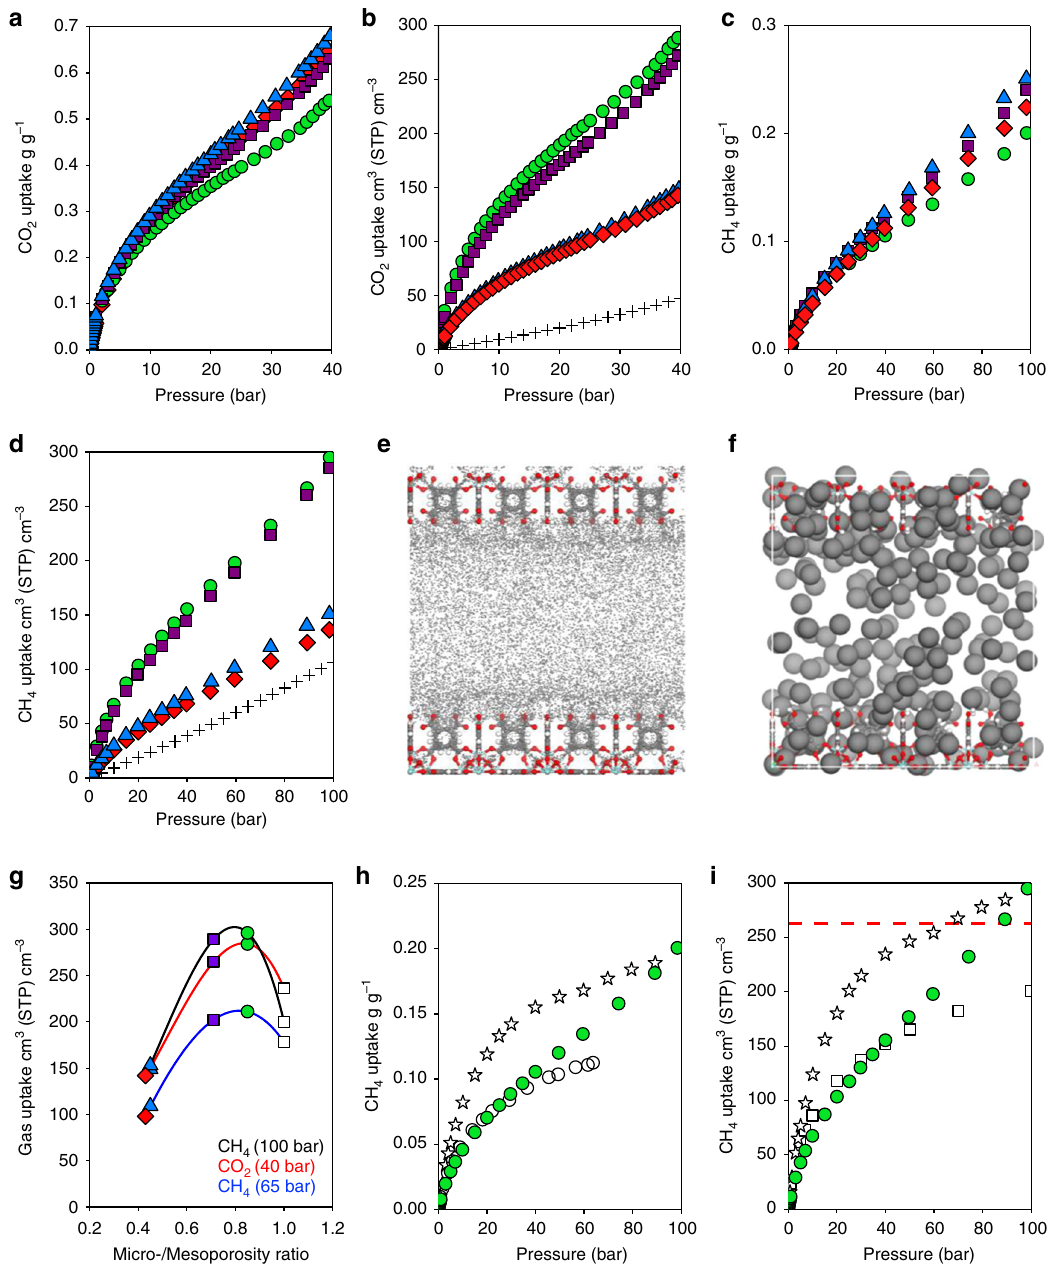
Fig. 5 Experimental and computational CO 2 and CH 4 adsorption. a Gravimetric and b volumetric CO 2 absolute adsorption isotherms at 298 K. c Gravimetric and d volumetric CH 4 absolute adsorption isotherms at 298 K. The data correspond to monoliths UiO-66_A (blue triangles), UiO-66_B (red diamonds), UiO-66_C (purple squares), UiO-66_D (green circles) and an empty tank (black crosses). e The density distribution and f , a snapshot of CH 4 (grey spheres) uptake into UiO-66 crystals (Zr; blue, O; red, C; grey and H; white) separated by a 2.3 nm mesopore (comparable with mono UiO-66_D) at 80 bar. g Gas uptake amongst the different experimental and GCMC isotherms as a function of micro-/mesopore ratio, highlighting the ratio at which maximum uptake occurs. h Comparison of gravimetric absolute CH 4 adsorption isotherms for mono UiO-66_D, UiO-66 powder (white circles) 47 and 28 . i Comparison of experimental isotherms for absolute volumetric CH mono HKUST-1 (white stars) 4 uptake in mono UiO-66_D (green circles) and 28 to computationally simulated purely microporous/defect-free UiO-66 (white squares) at 298 K; the U.S. DOE volumetric CH mono HKUST-1 (white stars) 4 storage target of 263 cm 3 (STP) cm − 3 (65 bar) is indicated by the dashed red